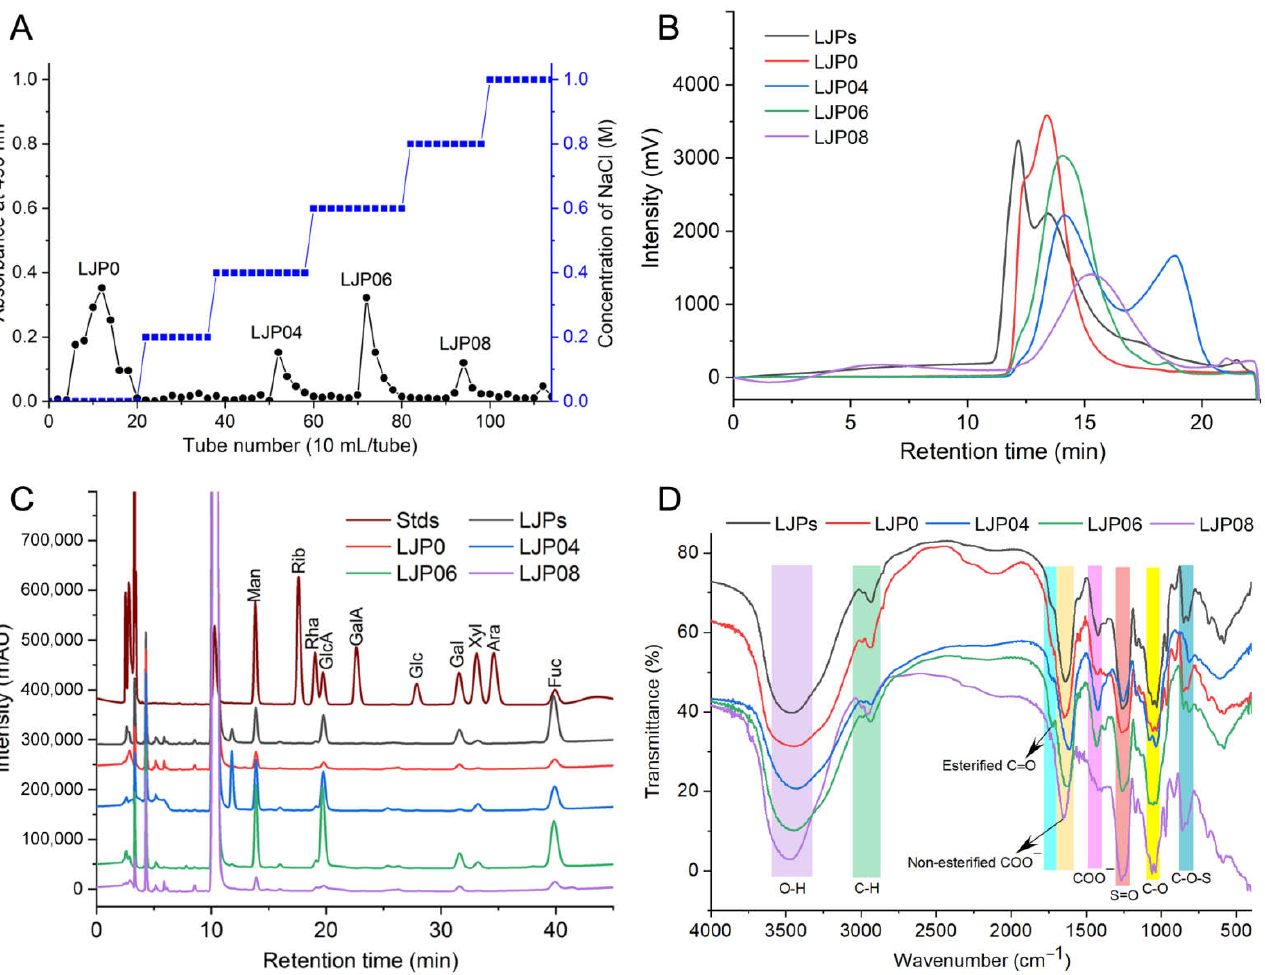
Figure 1. Preparation and physicochemical characteristics of LJPs and the purified fractions. Step- wise elution curve of LJPs ( A ), HPGPC profiles ( B ), monosaccharide compositions ( C ), and FT-IR spectra ( D ).